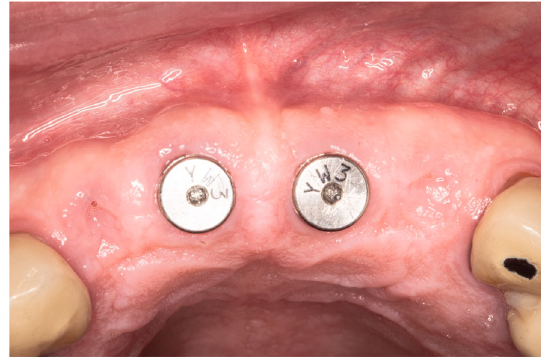
Figure 10: Final bridge delivery.